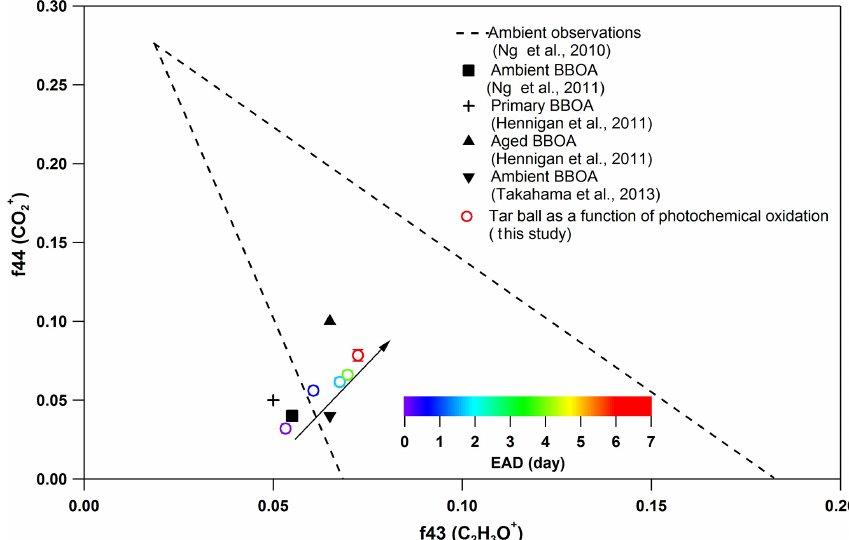
Figure 7. Comparison of f 44 and f 43 values from ambient data sets (Ng et al., 2010) and values from ambient biomass burning organic